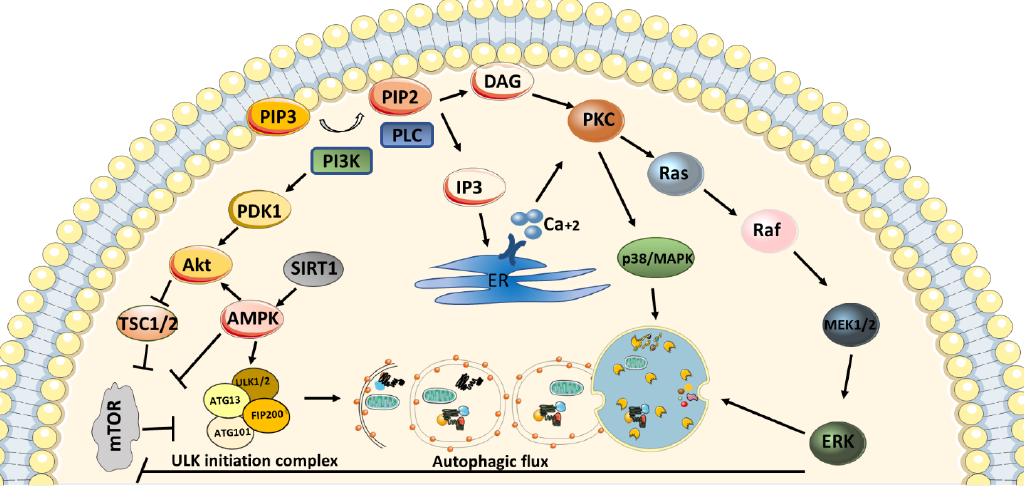
Figure 4. Schematic representation of main signaling pathways playing role in autophagy activation. In the figure, arrows indicate activation, whereas bars show inhibition. Activation of phosphatidylinositol 3-kinase (PI3K) results in dephosphorylation of phosphatidylinositol [3,4,5]-trisphosphate (PIP3) and generates phosphatidylinositol (4,5)-bisphosphate (PIP2). Phospholipase C (PLC) hydrolyses PIP2 and produces inositol-1, 4,5-trisphosphate (IP3) and diacylglycerol (DAG). IP3 translocates to endoplasmic reticulum (ER) in order to release